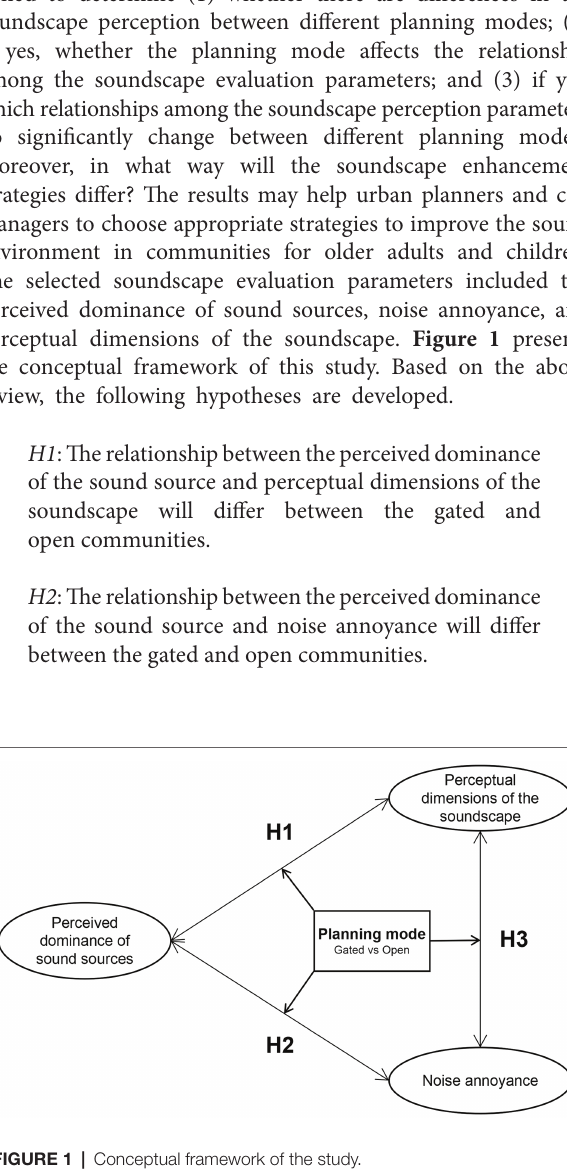
FIGURE 1 | Conceptual framework of the